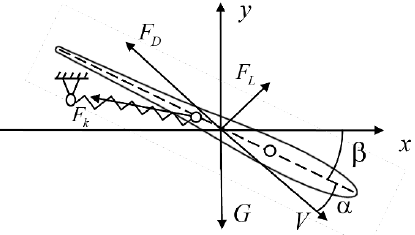
Figure 7. The force analysis of the hydrofoil during the gliding phase.